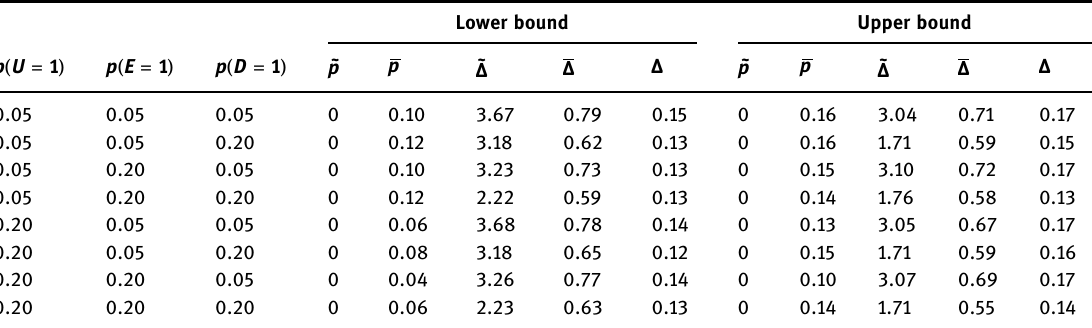
Table 2: Simulation results with σ 1 = . p ˜ and p are the proportions of times that AS ’ bounds and our bounds are tighter than DV ’ s bounds, respectively. Δ˜ , Δ and Δ are the mean absolute distance between the log of the bound and the log of the true risk ratio for AS ’ bounds, our bounds and DV ’ s bounds, respectively Lower bound Upper bound p U 1 ( = )